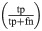
Forest plots of sensitivity and specificity.Sensitivity was defined as (tptp+fn) and specificity as (tntn+fp). tn: true negative; tp: true positive; fn: false negative; fp: false positive. All numbers have been rounded up or down to the closest second decimal.